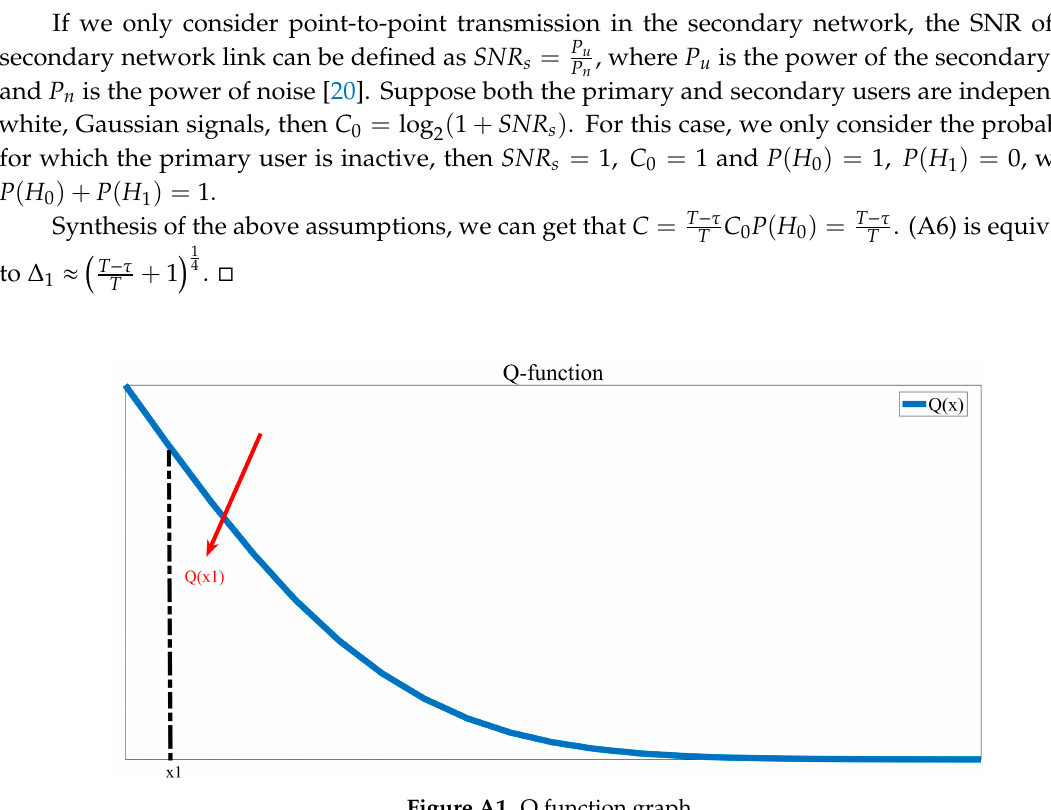
Figure A2. The diagram of A and B.